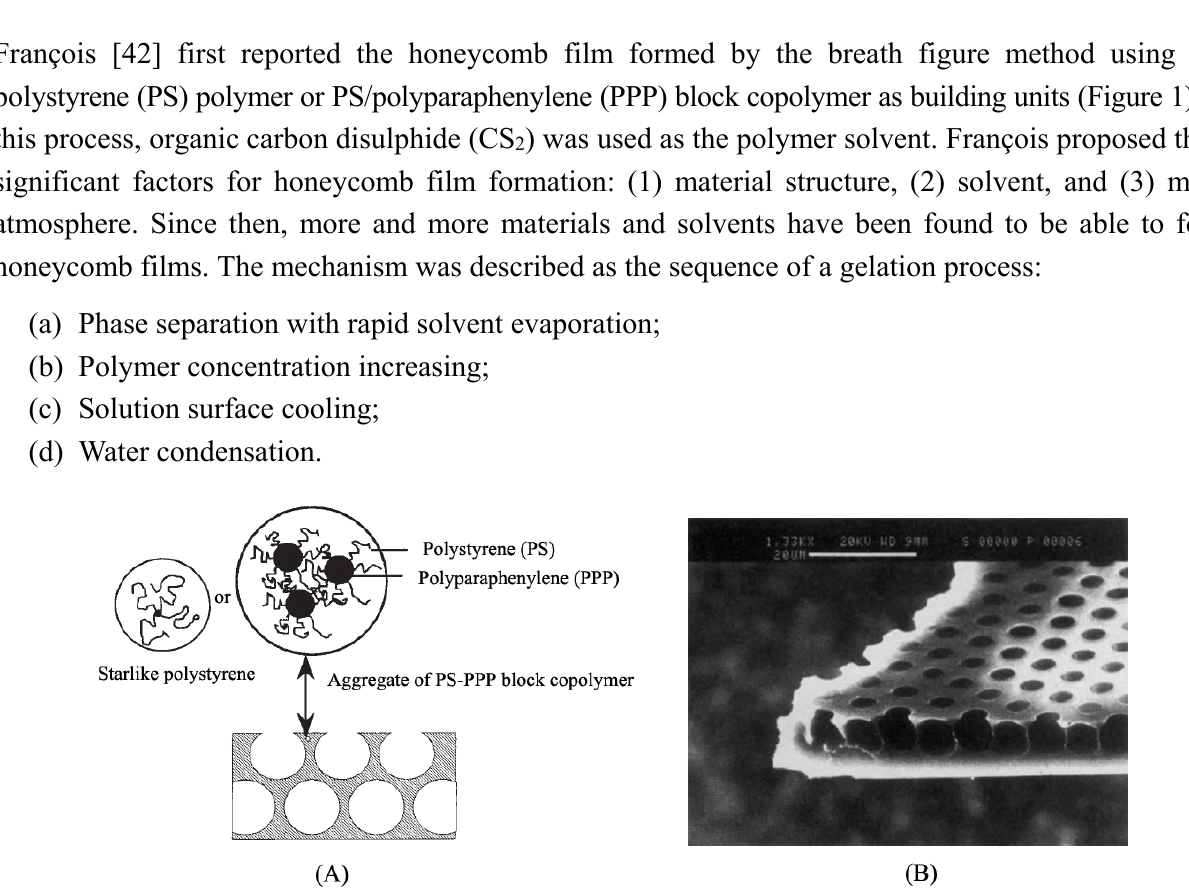
Figure 1. ( A ) Schematic drawing of the honeycomb film formation of star PS polymer or PS-PPP block copolymer; ( B ) SEM photograph of the PS-PPP honeycomb films, with copyright permission from